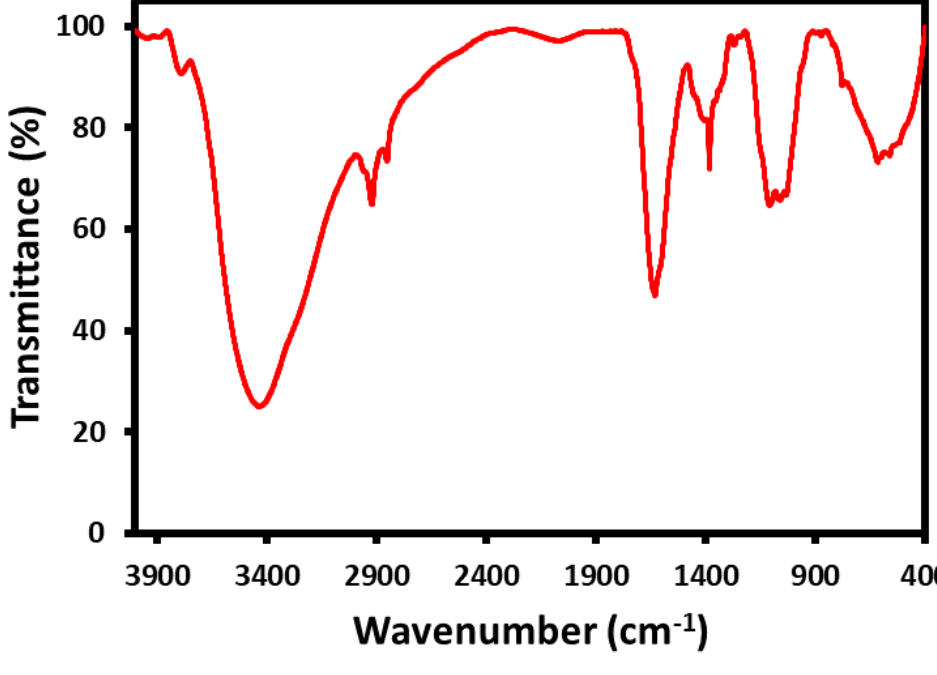
Figure 2. FT-IR analysis of MAL-CNPs.